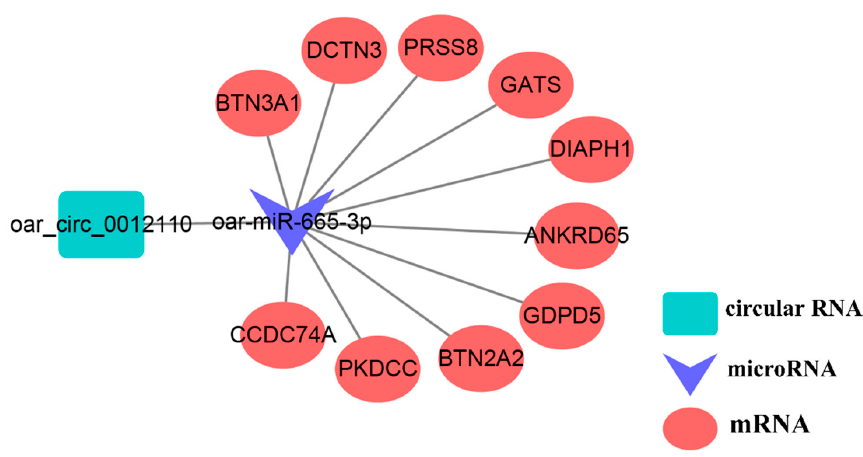
Figure 9. Predicted competing endogenous RNA (ceRNA) network involving oar_circ_0012110.